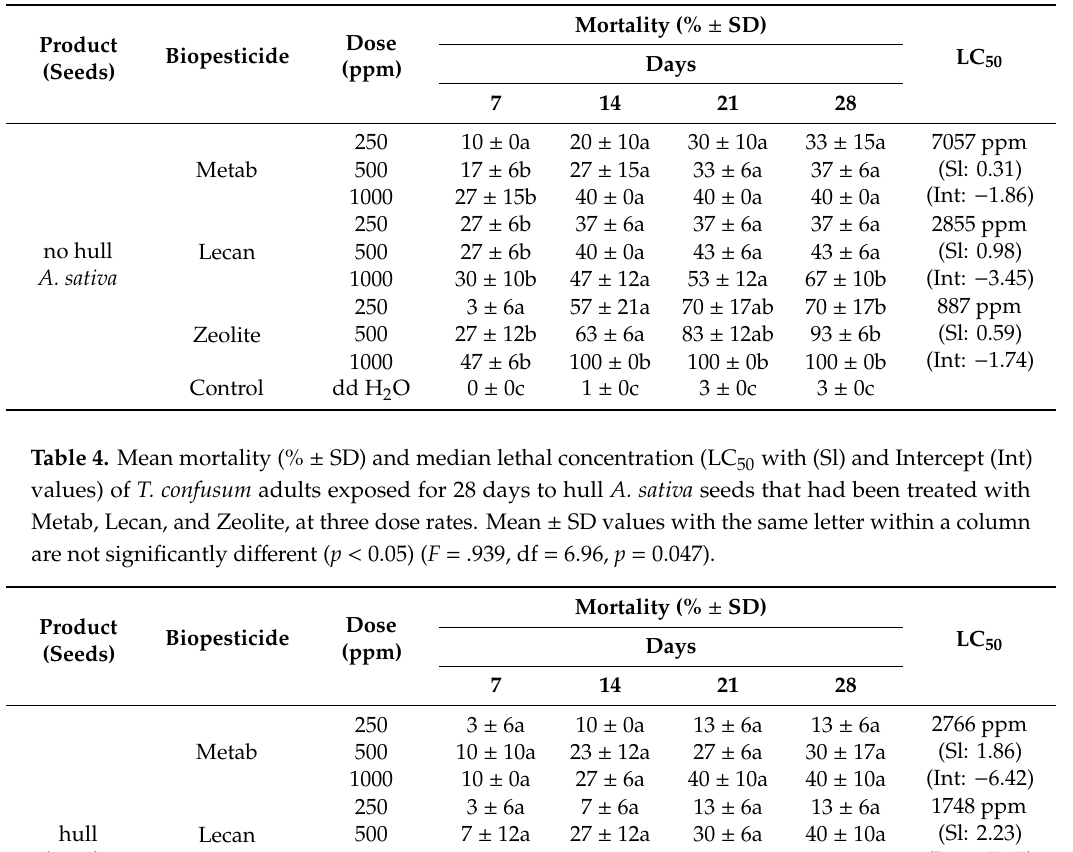
Table 3. Mean mortality (% ± SD) and median lethal concentration (LC 50 with (Sl) and Intercept (Int) values) of T. confusum adults exposed for 28 days to no hull A. sativa seeds that had been treated with Metab, Lecan and Zeolite, at three dose rates. Mean ± SD values with the letter within a column are not significantly di ff erent ( p < 0.05) ( F = 1.586, df = 6.96, p = 0.025).